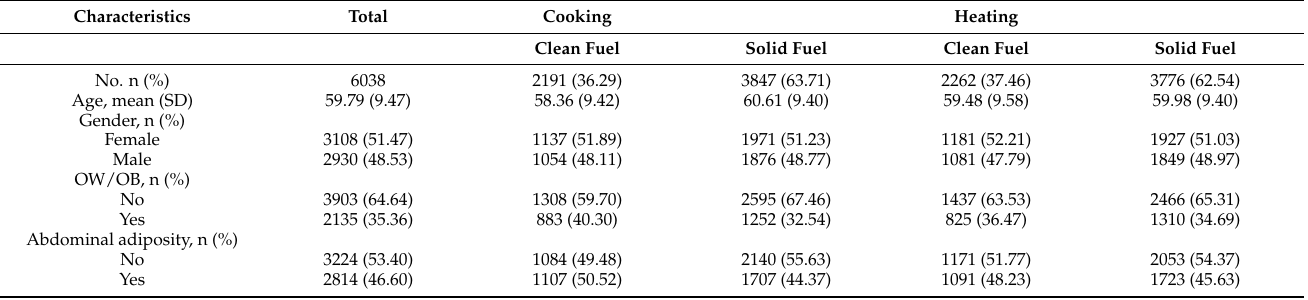
Table 1. Baseline characteristics of 6038 participants by household solid fuel